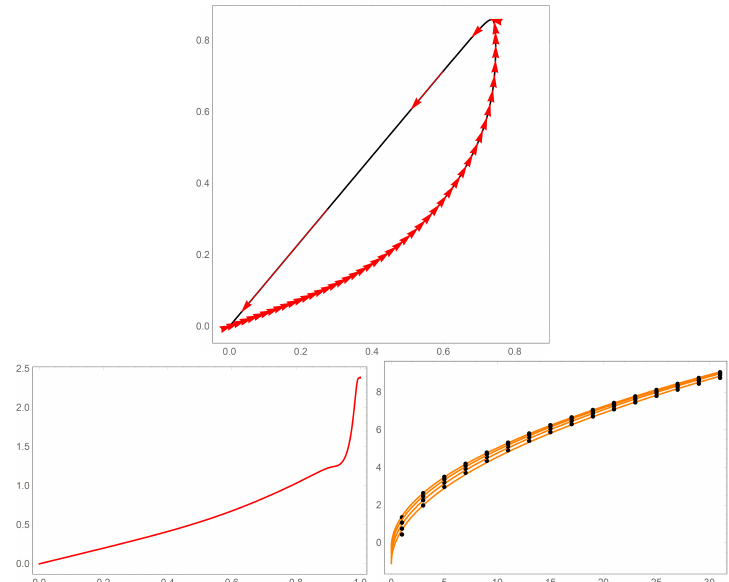
Figure 5. Top: Parametric plot P ( 3 ) ( ρ ; p ) (black curve) superimposed with red vectors indicating the “velocity” along the curve. One notices a modest “acceleration” until the curve turns back towards the origin whereupon the acceleration is markedly increased. Bottom left: the arclength (ordinate) versus ρ (abscissa) for P ( 3 ) ( ρ ; p ) . Bottom right: Arclength of P ( k ) ( ρ ; p ) for p = 1,2, . . . ,30 (black dots) associated √ p + c (orange curve). The top curve is for with the parametric plots shown in Figure 4 fitted to A k = 1 and the bottom curve is for k = 8. Fit parameters ( A , c ) for k = 1, k = 2, k = 4, k = 8 respectively: ( 1.7880, − 1.1038 ) , ( 1.7571, − 0.7926 ) , ( 1.7175, − 0.5052 ) , ( 1.6794, − 0.2701 )